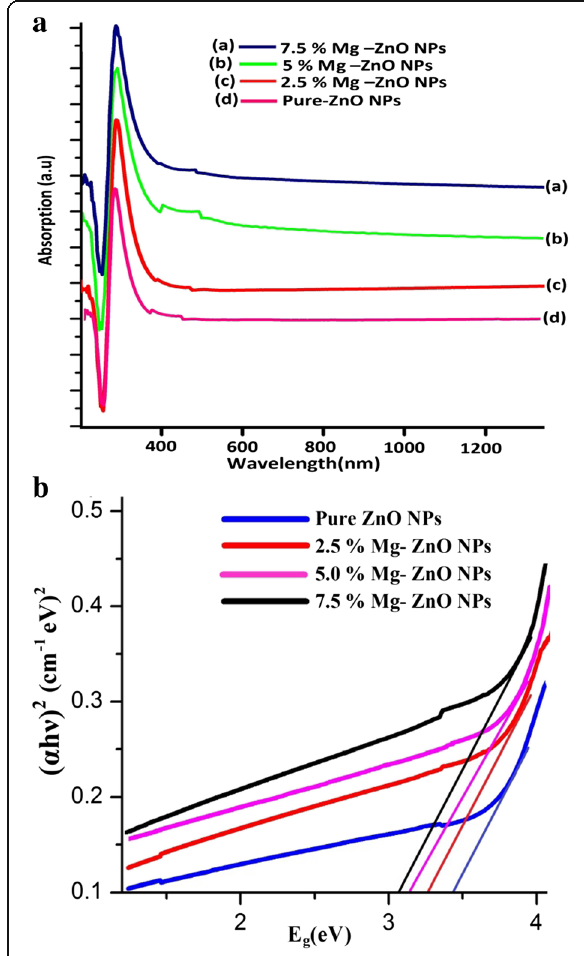
Fig. 5 a Optical absorption and b band gap energy ( E g ) for pure and Mg-doped ZnO NPs Fig. 6 Photoluminescence spectrum of pure and Mg-ZnO